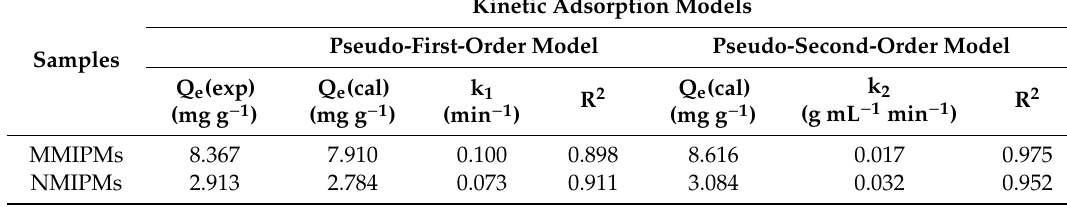
Table 2. The fitting parameters of the pseudo-first-order and pseudo-second-order kinetic adsorption models for TC.